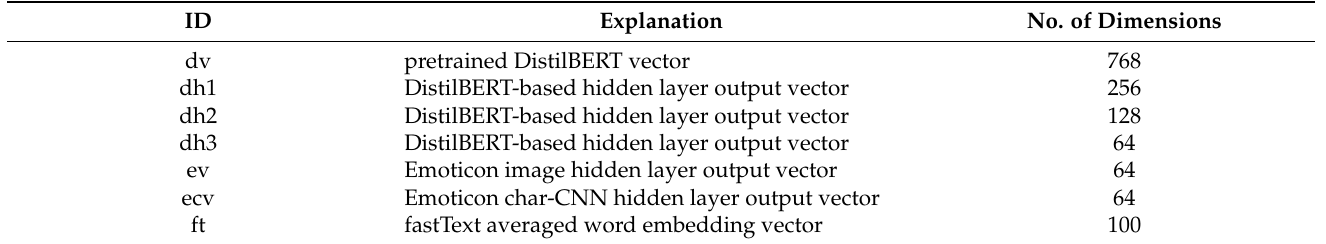
Table 5. Features